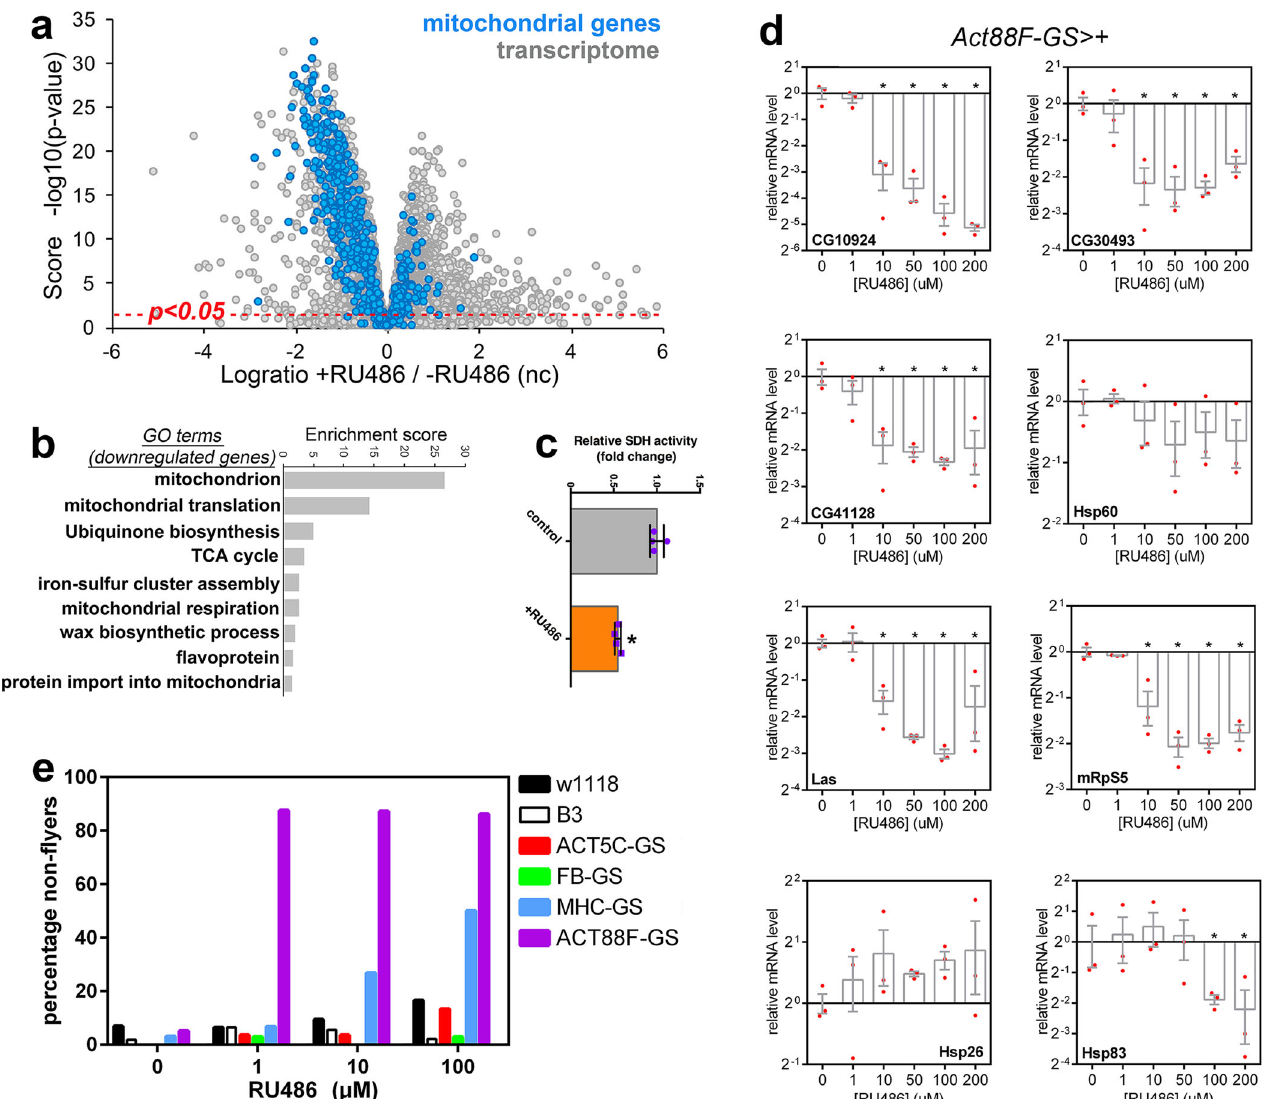
Fig. 1 Transcriptional and functional defects induced by RU486 in skeletal muscle. a RNA-seq of thoracic skeletal muscle from Drosophila Act88F-GS fl ies treated with 100 µM RU486 for 10 days and untreated controls ( – RU). RU486 represses the expression of nuclear-encoded mitochondrial genes, which is the fi rst category of genes downregulated by RU486 ( b ). The transcriptome and the totality of mitochondrial genes are shown in gray and blue, respectively. The x axis reports the log ratio of gene expression changes of RU486-treated fl ies versus untreated controls, whereas the y axis reports the signi fi cance score, which is the – log10( P -value). Hence, values above the red line ( P < 0.05) correspond to signi fi cantly regulated genes. No GO categories are identi fi ed in genes with RU486-upregulated expression. c RU486 treatment decreases SDH activity in the muscle of Act88F-GS-Gal4 fl ies ( n = 4, SD, * P < 0.05). d qRT-PCR analysis of skeletal muscle from Act88-GS-Gal4 fl ies treated with RU486. Consistent with RNA-seq data, qPCR analysis con fi rms that the expression of mitochondrial genes ( CG10924 , CG30493 , CG41128 , Hsp60 , Las , and mRpS5 ) declines in response to RU486 treatment in a dose-dependent manner. Conversely, RU486 induces the expression of the cytoplasmic chaperones Hsp26 and Hsp83 ( n = 3, SD, * P < 0.05). e In fl ies with muscle expression of GS-Gal4 ( Mhc-GS-Gal4 and Act88F-Gs-Gal4 ), treatment for 1 week with 1, 10 or 100 µM RU486 leads to high percentages of fl ightless fl ies, compared with untreated controls. However, RU486 exerts minimal in fl uence on the fl ight capacity of WT strains ( w 1118 and B3 ) and non-muscle GS-Gal4 strains